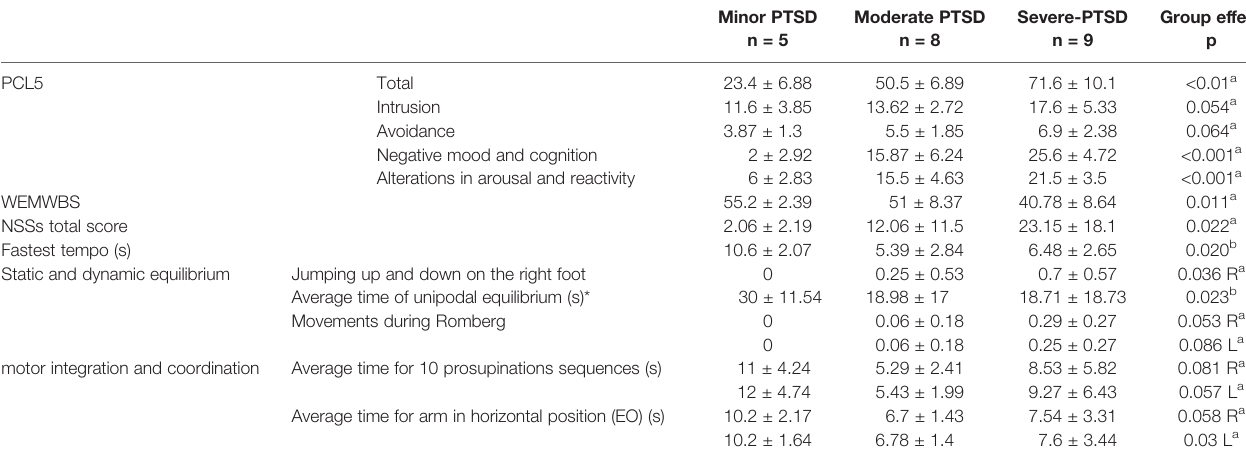
TABLE 2 | Mean scores and standard deviations (±) according to the three groups for the items of the PCL5, WEMWBS, and PASS with signi fi cant group